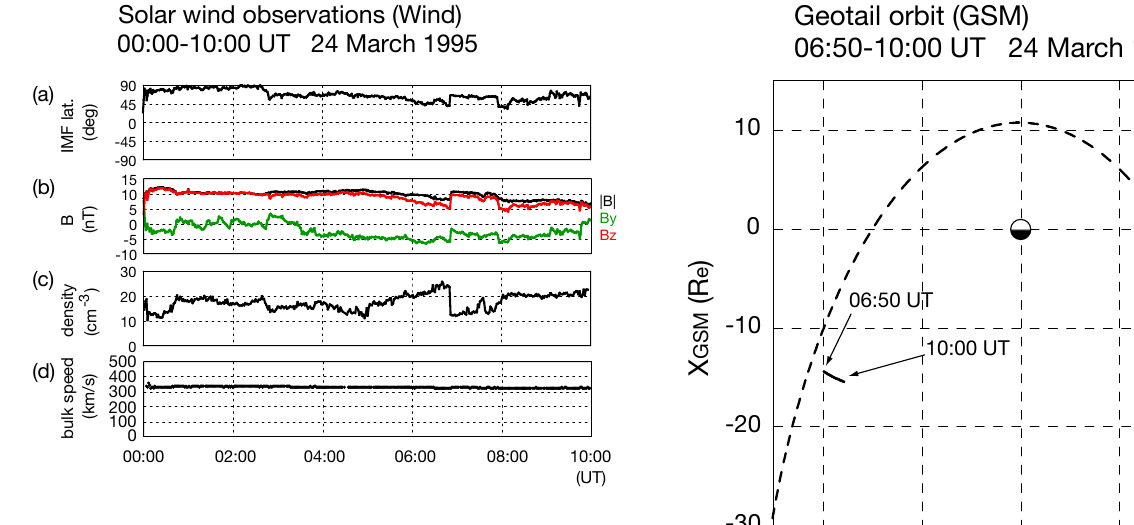
Fig. 1. Solar wind observations by Wind ( X ∼ 219 R E ) between 00:00–10:00 UT on 24 March 1995. From the top, (a) the latitudi- nal angle of the IMF, (b) strength (black), Y (green), and Z (red) components of the IMF, (c) proton density, and (d) bulk flow speed are presented. The convection time ( ∼ 70min) is not included in the figure. parallel (blue) to the local magnetic field, (d) proton tem- peratures, (e) V X (blue) and V Y (green) of bulk proton ve- locity, and (f) three components of the magnetic field are presented. Locations of the Geotail spacecraft are given at the bottom of the figure. Large perturbations in the mag- netic field, the velocity, and the electron and proton tem- peratures are attributed to encounters with the vortical struc- tures of the KH instability around the boundary. Concern-